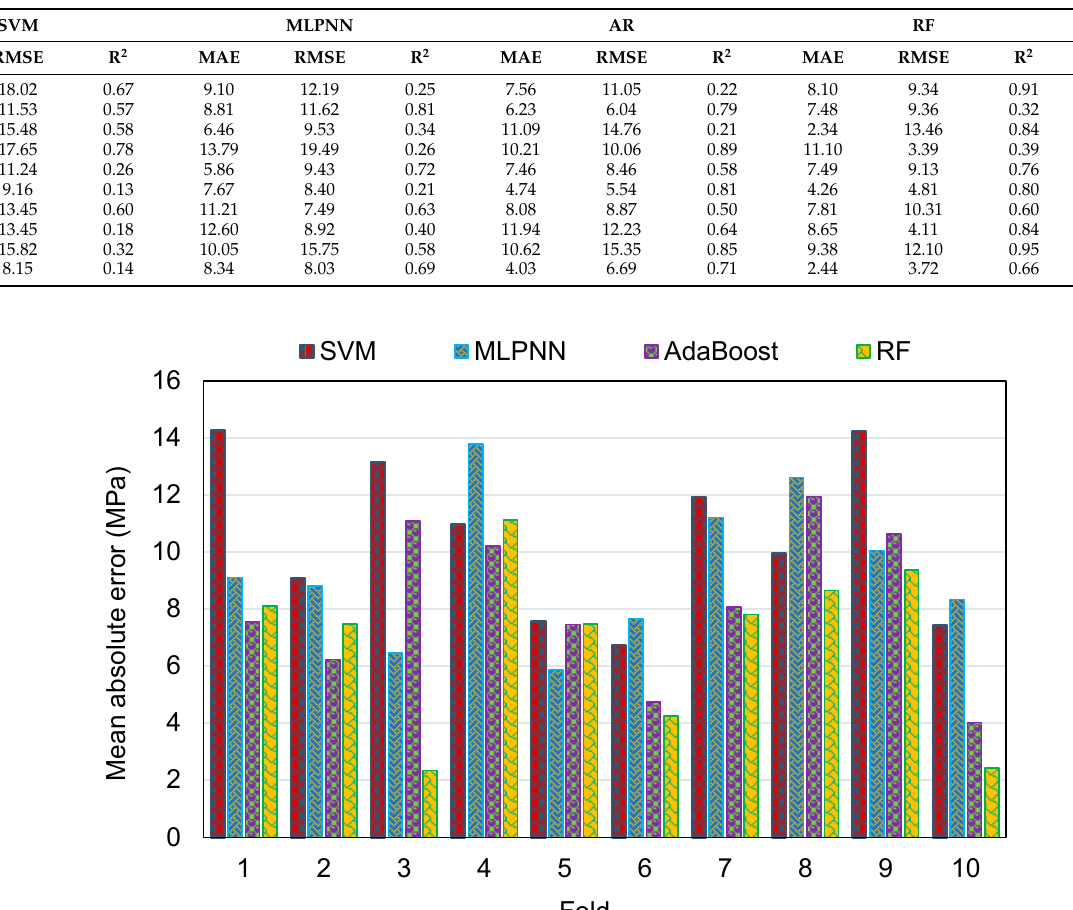
Table 3. Results of the k-fold process.